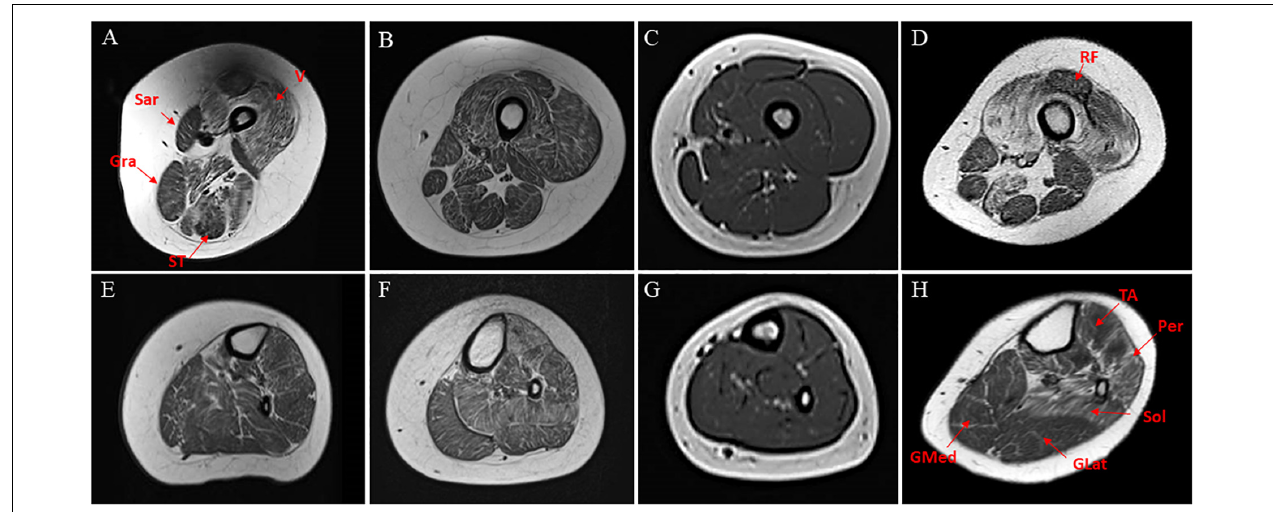
FIGURE 1 | Transverse T1-weighted MRI of thighs and calf muscles of patients harboring INPP5K mutations. Pt #1 (A,D) , Pt #2 (B,E) , Pt #3 (C,F) , pt #4 (D,G) . At thigh level, an involvement of vasti muscles (V) are relative sparing of rectus femoris (RF) in patients #1and #4 (A,D) . In the posterior thigh, sartorius (Sar), gracilis (Gra), and to a lesser extent, semitendinosus (ST) were relatively spared (E,H) . At the lower leg level, anterolateral compartment (tibialis anterior-T ant- and peronei –Per-) and soleus (Sol) were similarly affected, with relative sparing of both gastrocnemii (GMed and GLat) muscles mainly in #4 (H) . In the youngest patient, the MRI did not disclose significant abnormalities (C,G) on T1-weighted